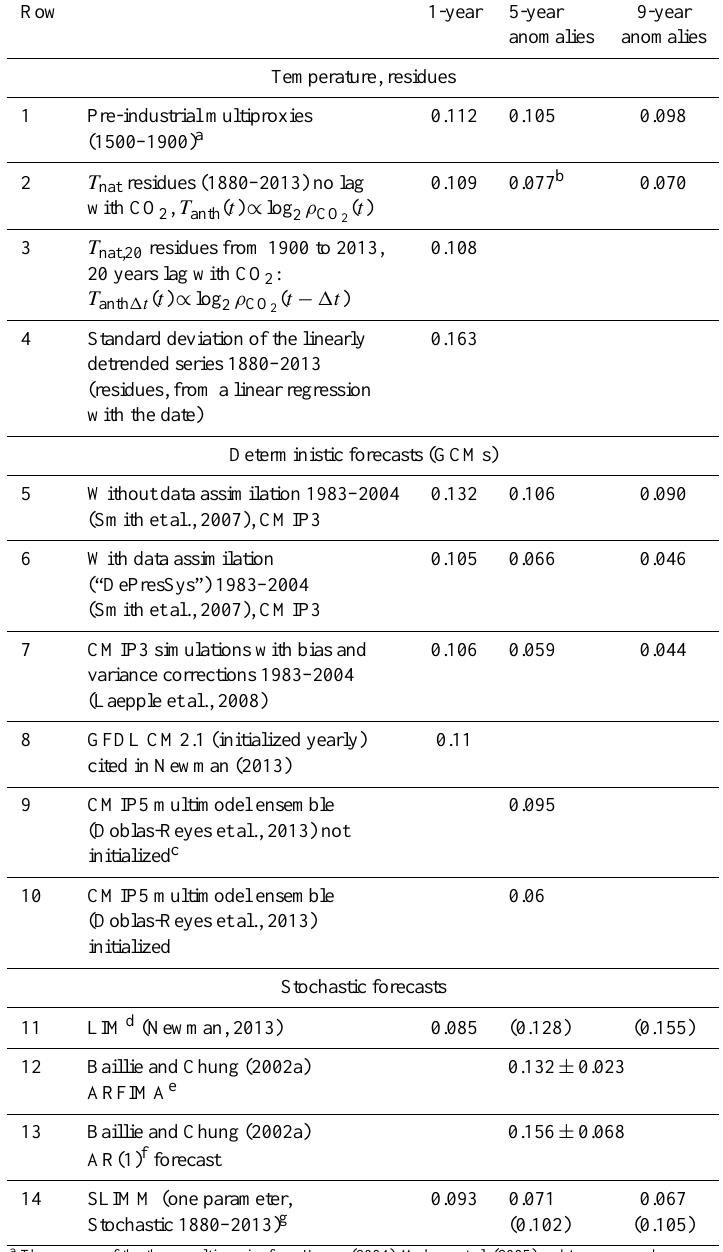
Table 1. A comparison of root mean square (RMS) variances (data residues) and hindcast errors (from deterministic and stochastic models) of global-scale, annual temperatures. See also Fig. 2. Note that the GCM hindcasts are all “optimistic” in the sense that they use the observed volcanic and solar forcings, and these would not be available for a true forecast. In comparison, the stochastic models forecast the responses to these (unknown) future